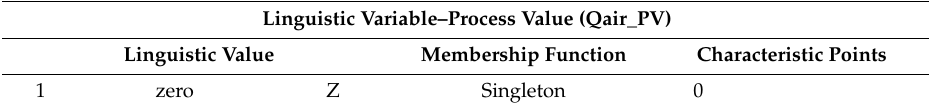
Table 5. The second version of the controller–Qair_PV.